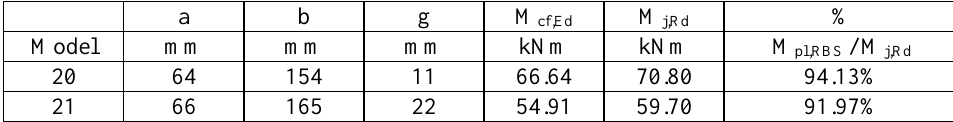
Results of stage 4